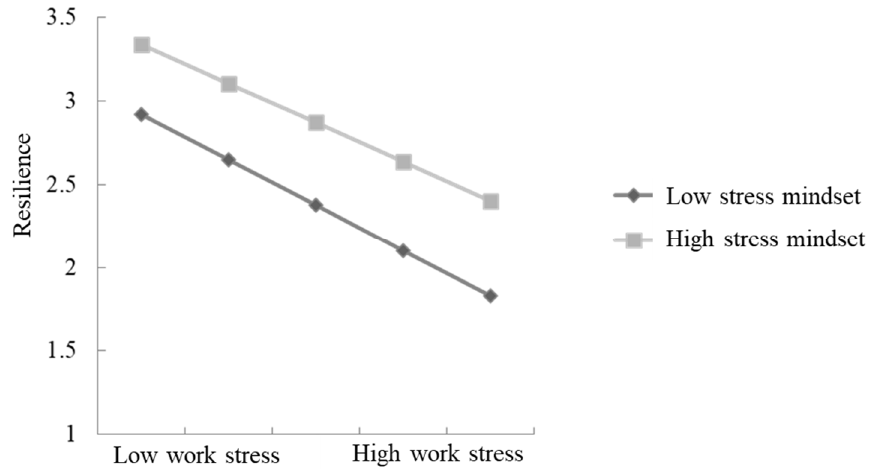
Figure 2. Simple slope analysis of stress mindset.